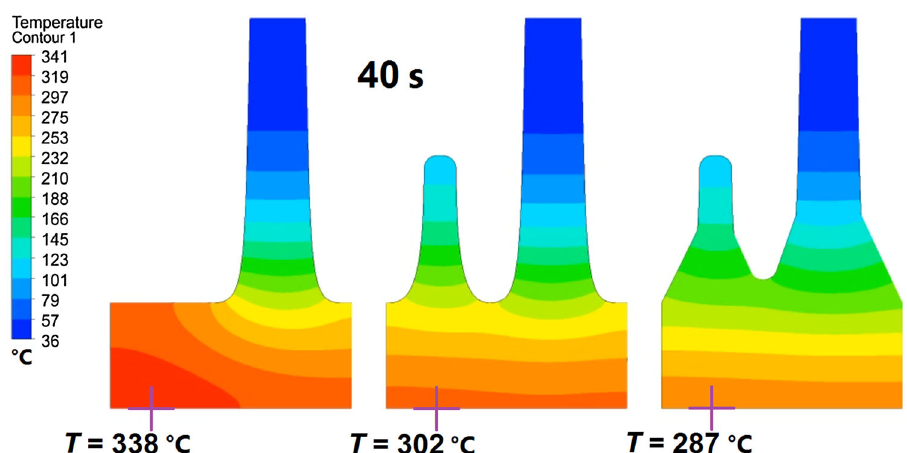
Fig. 6 Representation of braking with and without small cooling ribs at the end of an emergency stop scenario where power input is the highest and stopping time the